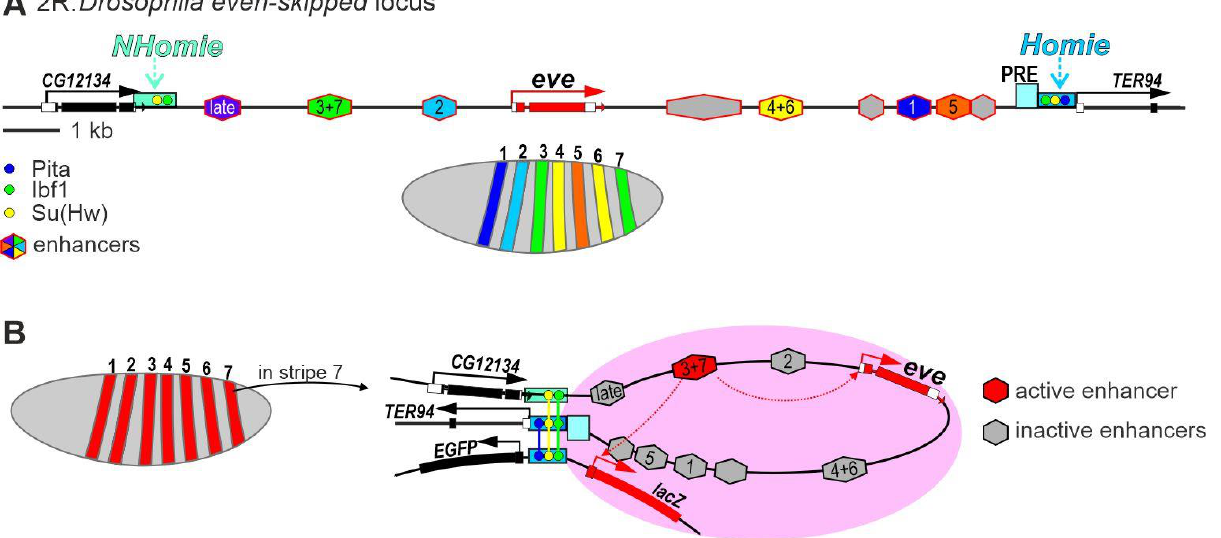
Figure 3. Model of transcriptional regulation of the pair-rule gene eve in early Drosophila embryos. ( A ) Schematic representation of the eve regulatory region that is flanked by the Homie and NHomie insulators. ( B ) Transcriptional activation model of the endogenous eve gene and the reporter transgene in the stripe 7 of early embryos. The interaction between the Homie and NHomie insulators forms a zone in which the activated eve enhancer can stimulate transcription of the endogenous eve promoter and the reporter gene promoter. Identical copies of the Homie insulator located in the endogenous eve locus and the transgene interact in head-to-head orientation, which brings only the reporter located on the head side of the insulator into the active eve enhancer